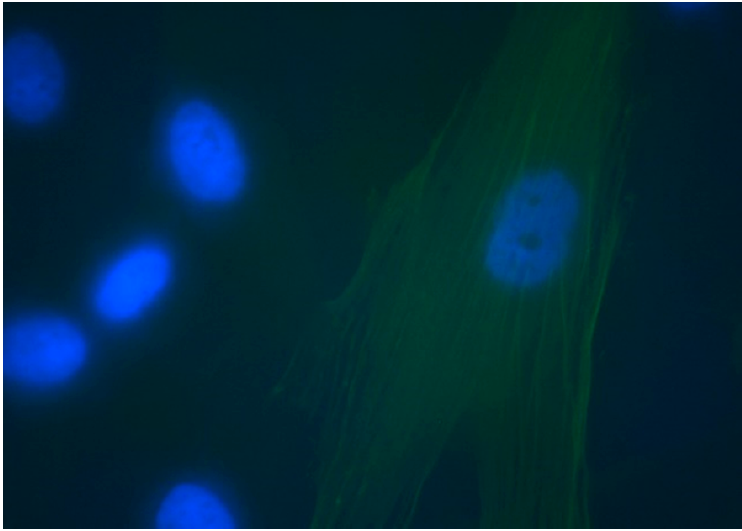
Figure 10. NOF 316 showing SMA expression after stimulation with 1 mg/mL Khat (magnification Figure 10. NOF316 showingSMA expression afterstimulation with1 mg/mLKhat (magnification × 100, Fluorescence at 1.3 s, DAPI at 0.07 ×100, Fluorescence at 1.3 s, DAPI at 0.07 s).